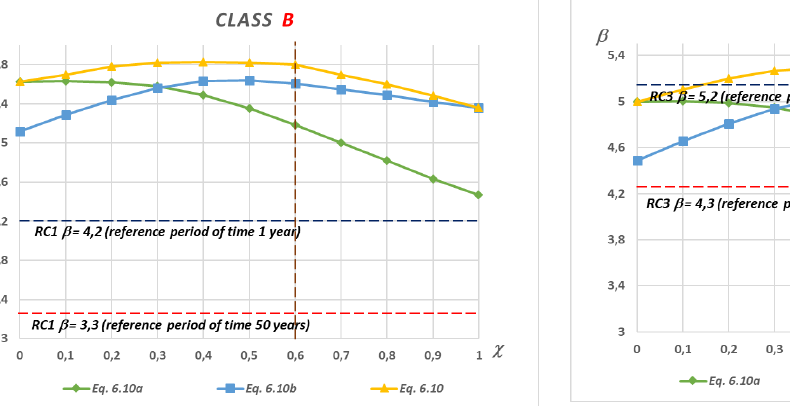
Figure 4: Reliability coeflcient curves β and load factor χ for the class B execution of works and three different combinations of